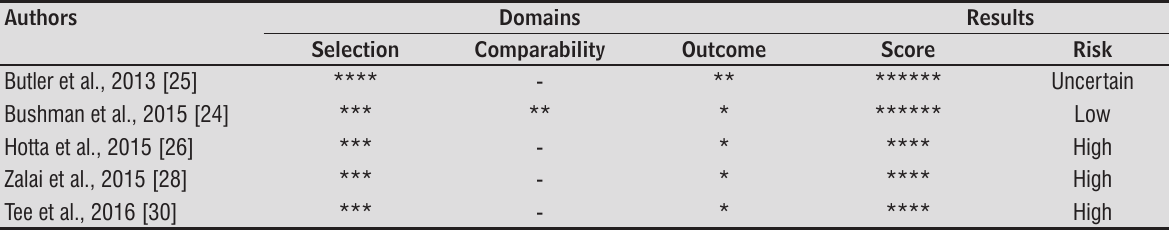
Table 3 - Risk of bias (NOS